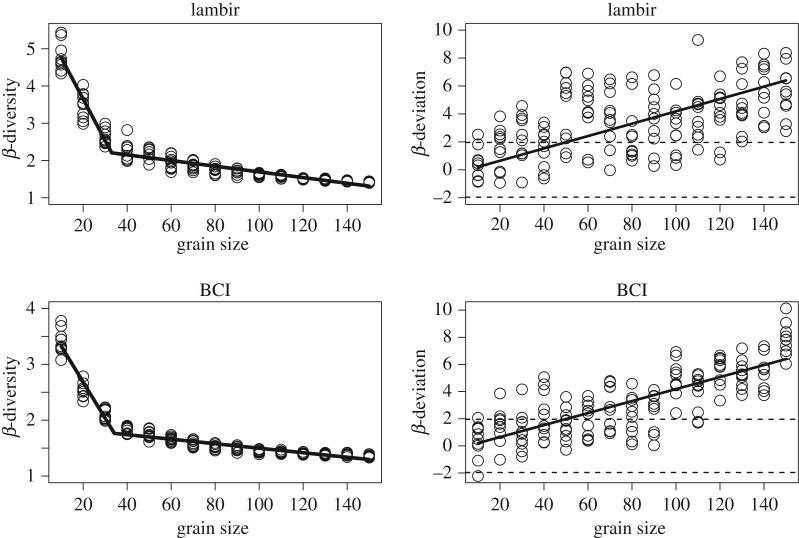
Variation in classical multiplicative β-diversity and β-deviation with increasing grain size in Lambir, Malaysia and BCI, Panama. β-deviation of zero indicates that the observed pattern does not differ from random sampling. The dashed lines in β-deviation plots represent the criterion (±1.96 s.d.) for assessing the statistical significance. The x-axis represents grain size at α-scale (e.g. 50 = 50 m × 50 m).